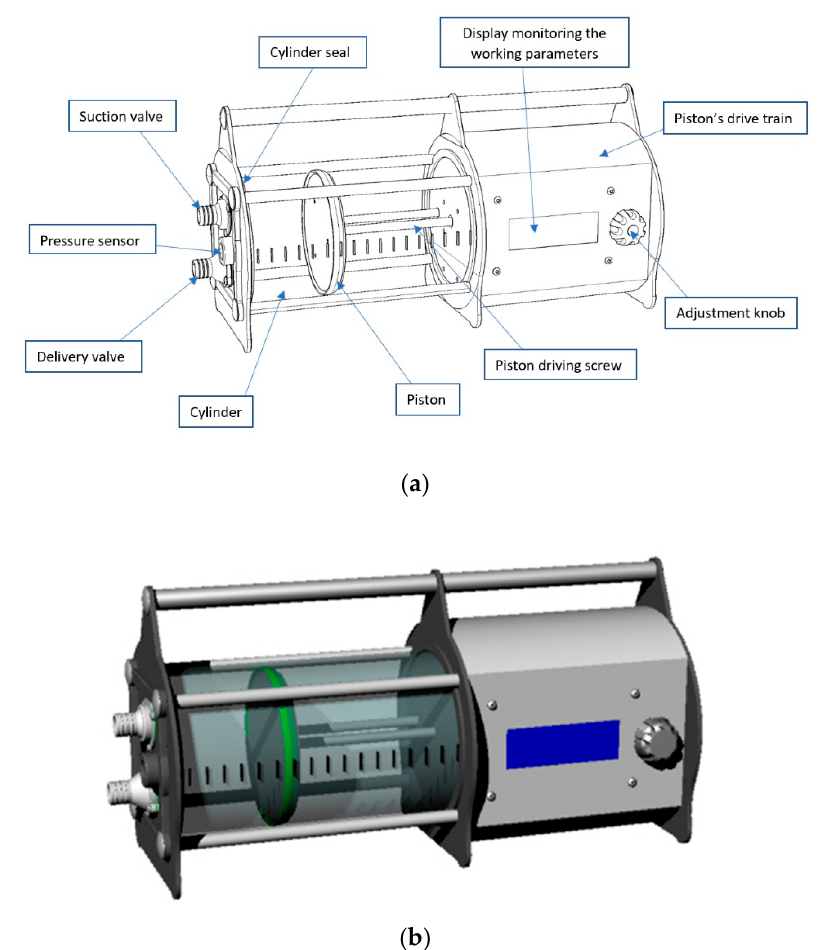
Figure 5. ( a ) A plan of the developed respiratory support device; ( b ) a model made in a CAD